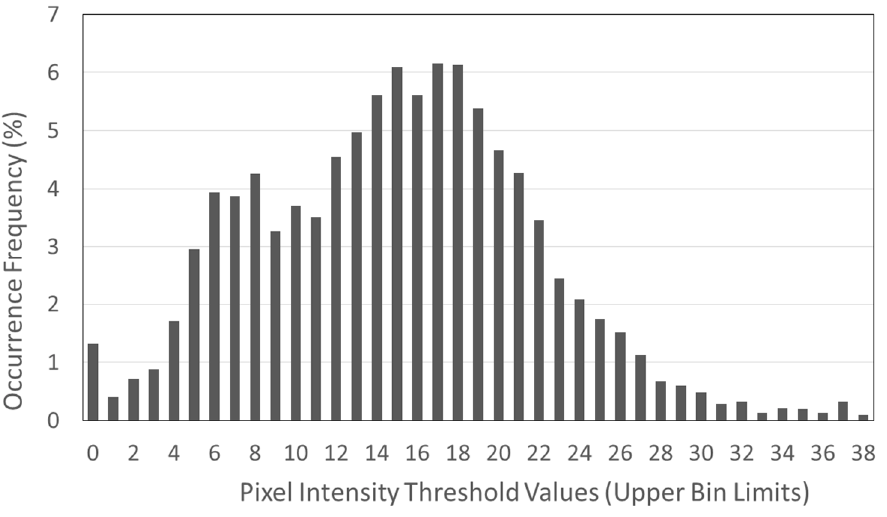
Figure 7. Scenario 33–14 threshold distribution histogram, indicating the most frequent pixel intensity thresholds of 17 and 18.